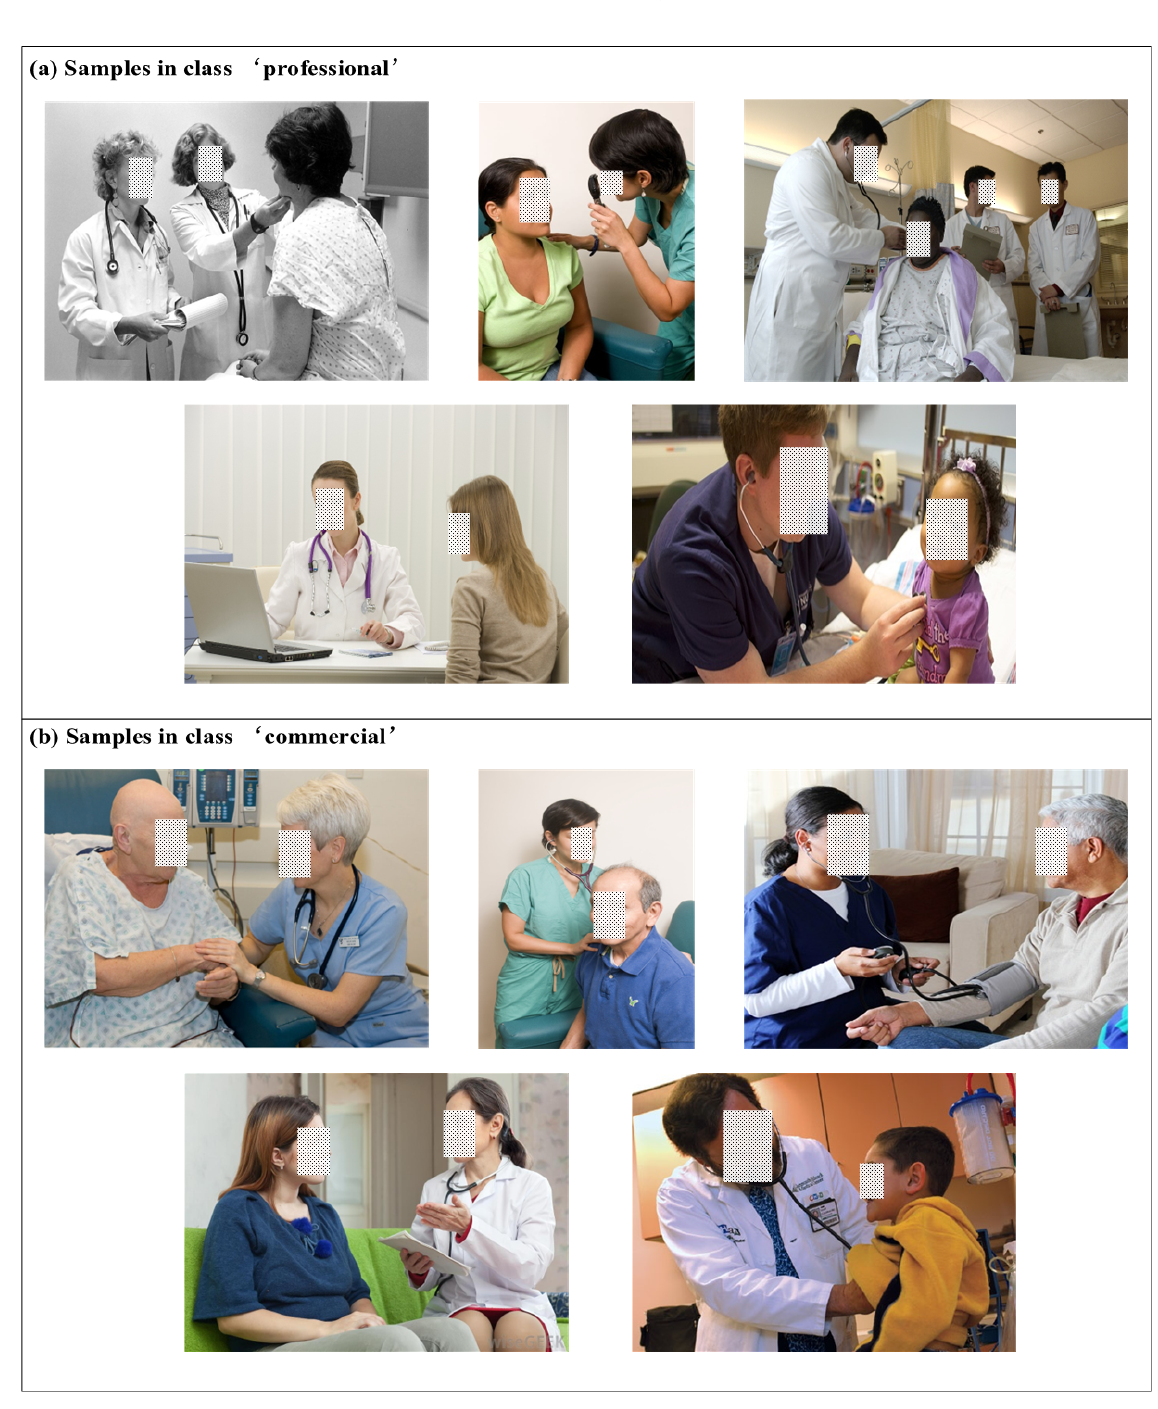
Figure 7. Similar samples in different